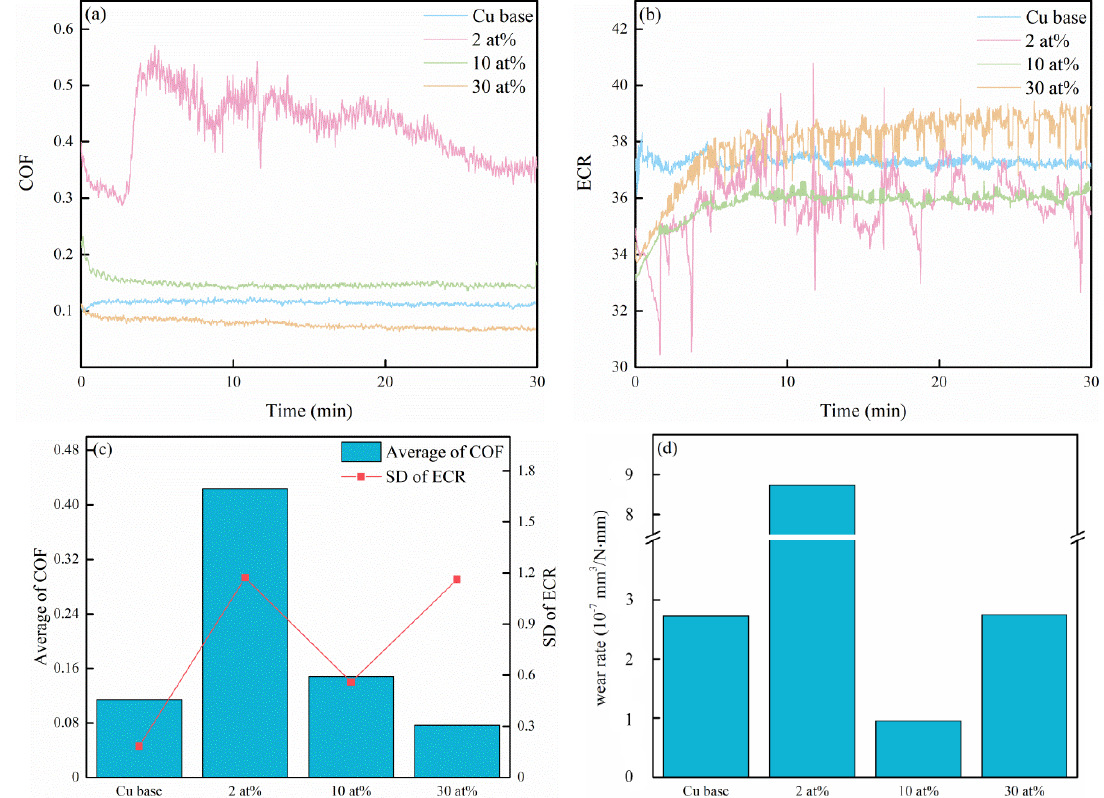
Fig. 6 Evolution of (a) COF, (b) ECR for the Cu base and TiN–Ag coating samples, (c) average of COF and SD of ECR values; (d) wear rate under grease (voltage: 1.5 V; load:15